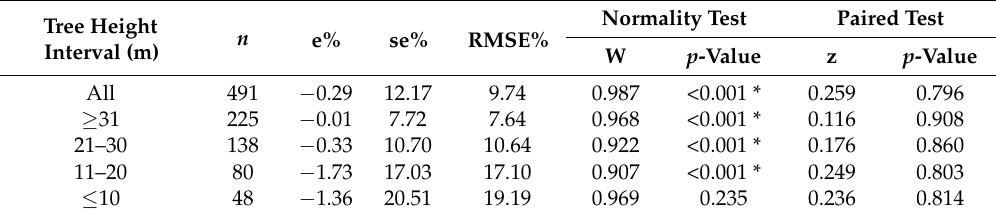
Table 4. Differences between measured and detected tree heights.